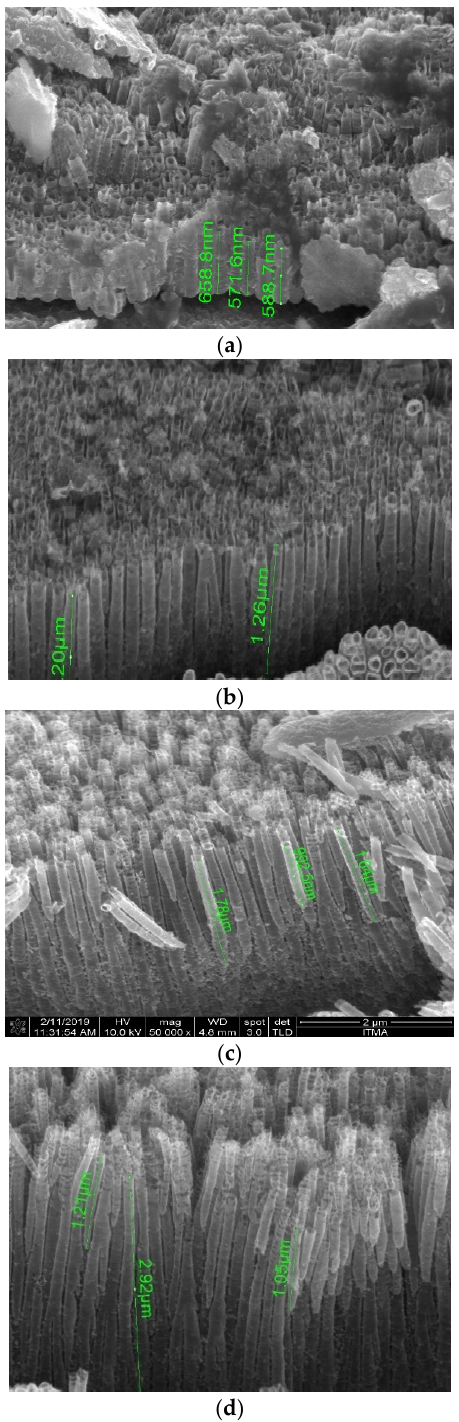
Figure 4. ( a ) CV curves at scan rate of 20 mV s − 1 , ( b ) GCD curves of TNTs at different applied voltage at current density of 0.02 mA cm − 2 and ( c ) variation of SC with applied voltage.